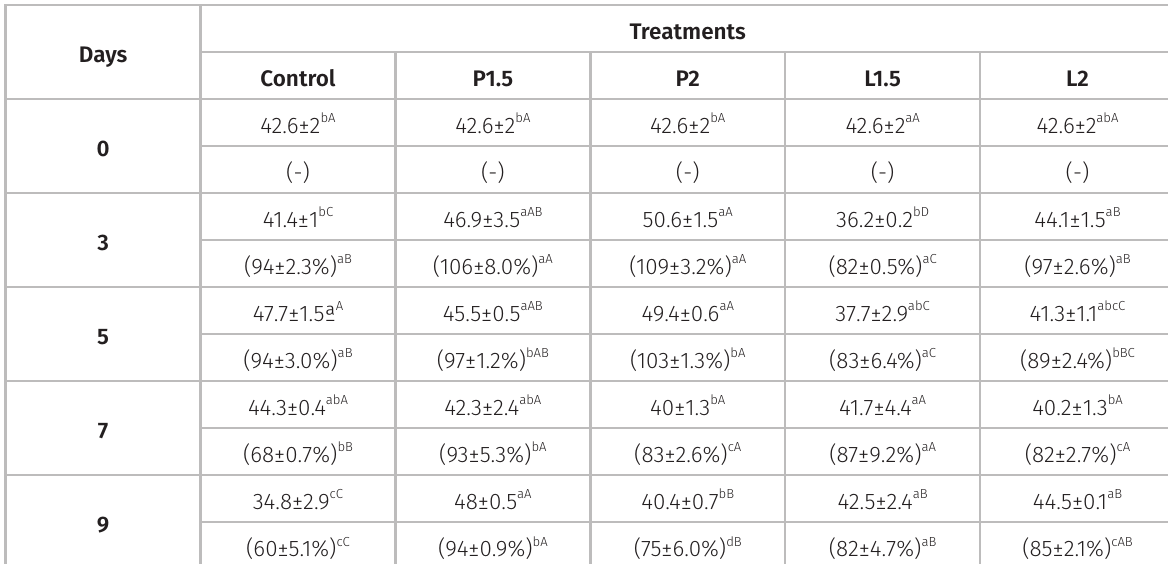
Table II. Carotenoids content (µg/g) of minimally processed papaya (uncoated and coated) and carotenoids retention (in parenthesis - %) of samples during 9 days of storage at 5